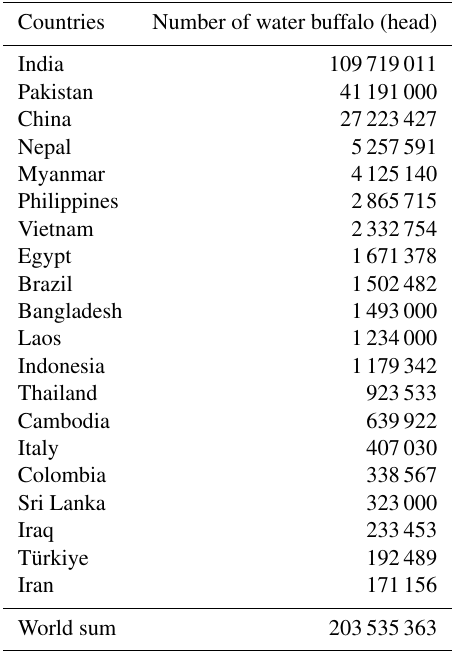
Table 1. Top 20 countries with the most water buffalo in the world (FAOSTAT,